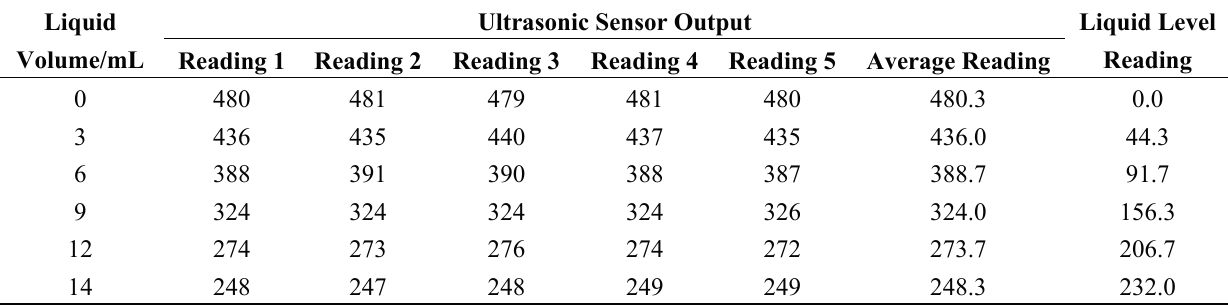
Table 2. The ultrasonic sensor calibration for liquid volume